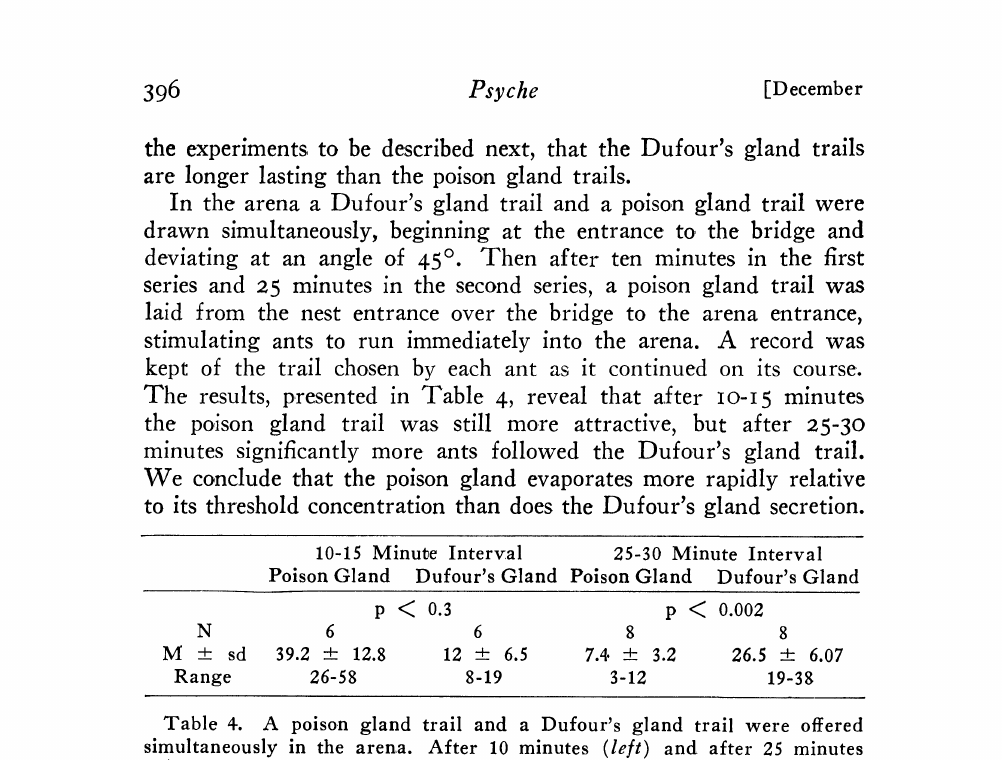
Table 4. A poison gland trail and a Dufour’s gland trail were offered simultaneously in the arena. After 10 minutes (left) and after 25 minutes (right) the ants were induced to approach the two trails, and their choices were recorded during a perio.d of minutes. The number o.f replications (N) and the mean and range of numbers of responding ants are